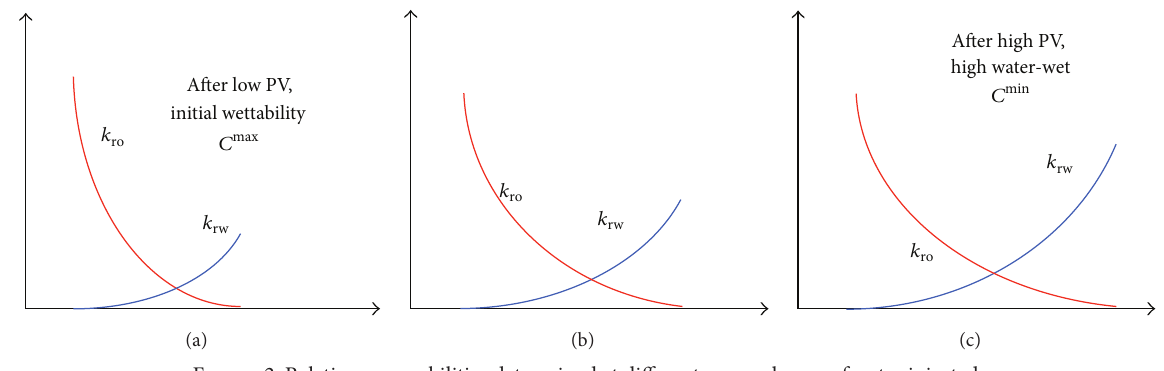
Figure 2: Relative permeabilities determined at different pore volumes of water